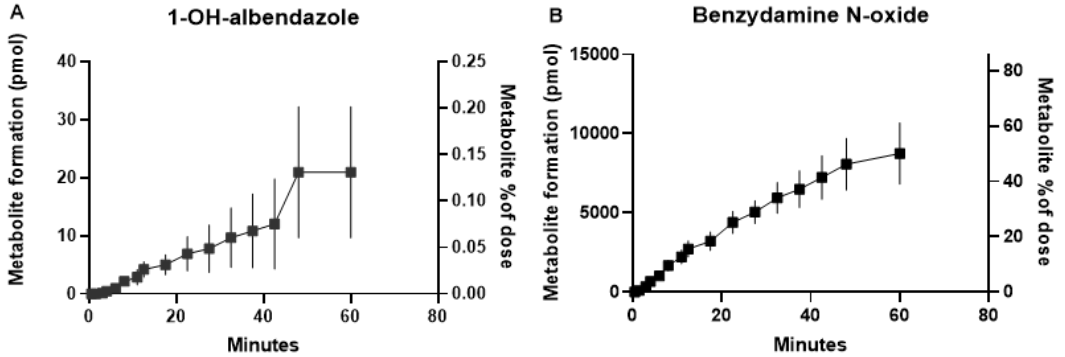
Figure 2. Metabolite formation, from the drug-metabolizing enzyme-selective substrates albendazole ( A ) and benzydamine ( B ), following nebulized administration of approximately 20 µg/kg bodyweight or 20 nmoles per lung to isolated perfused rat lung.